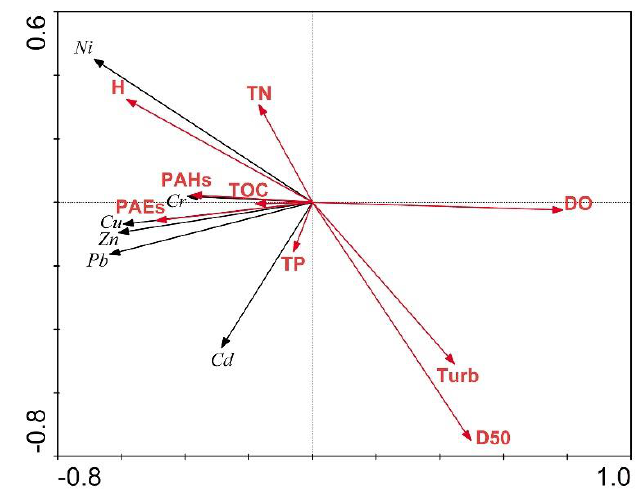
Figure 7. Redundancy analysis (RDA) of heavy metals and environment variables.